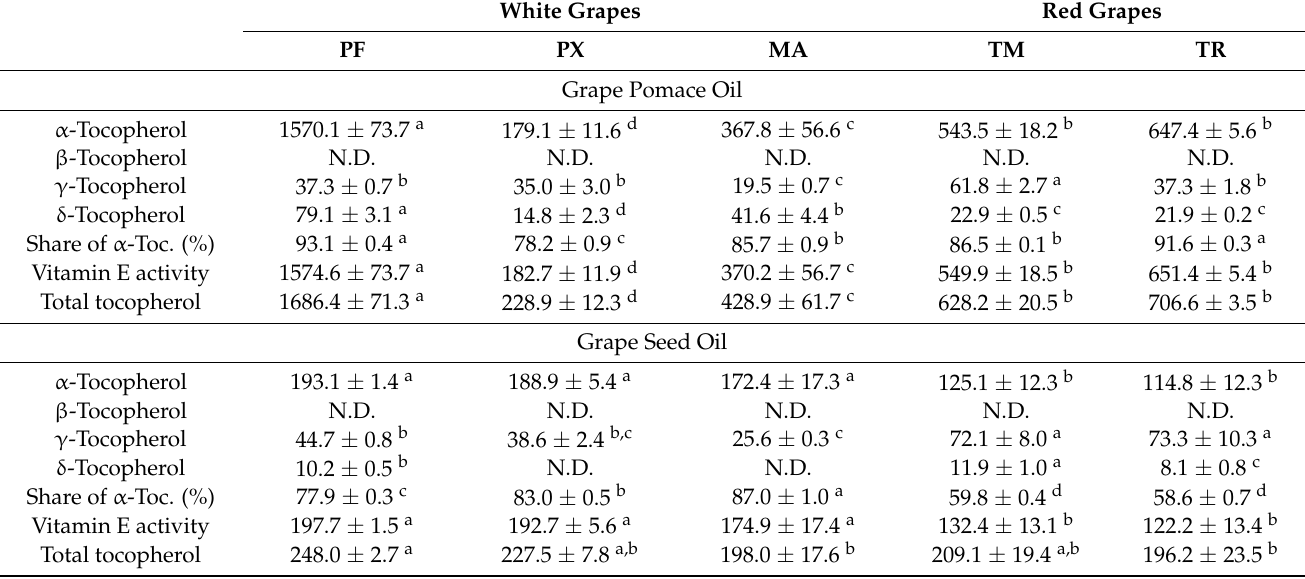
Table 4. Tocopherol contents and vitamin E activity of the by-product oils studied. Tocopherol content expressed as mg/kg by-product oil, and vitamin E activity expressed as α -tocopherol equivalent (mg/kg by-product